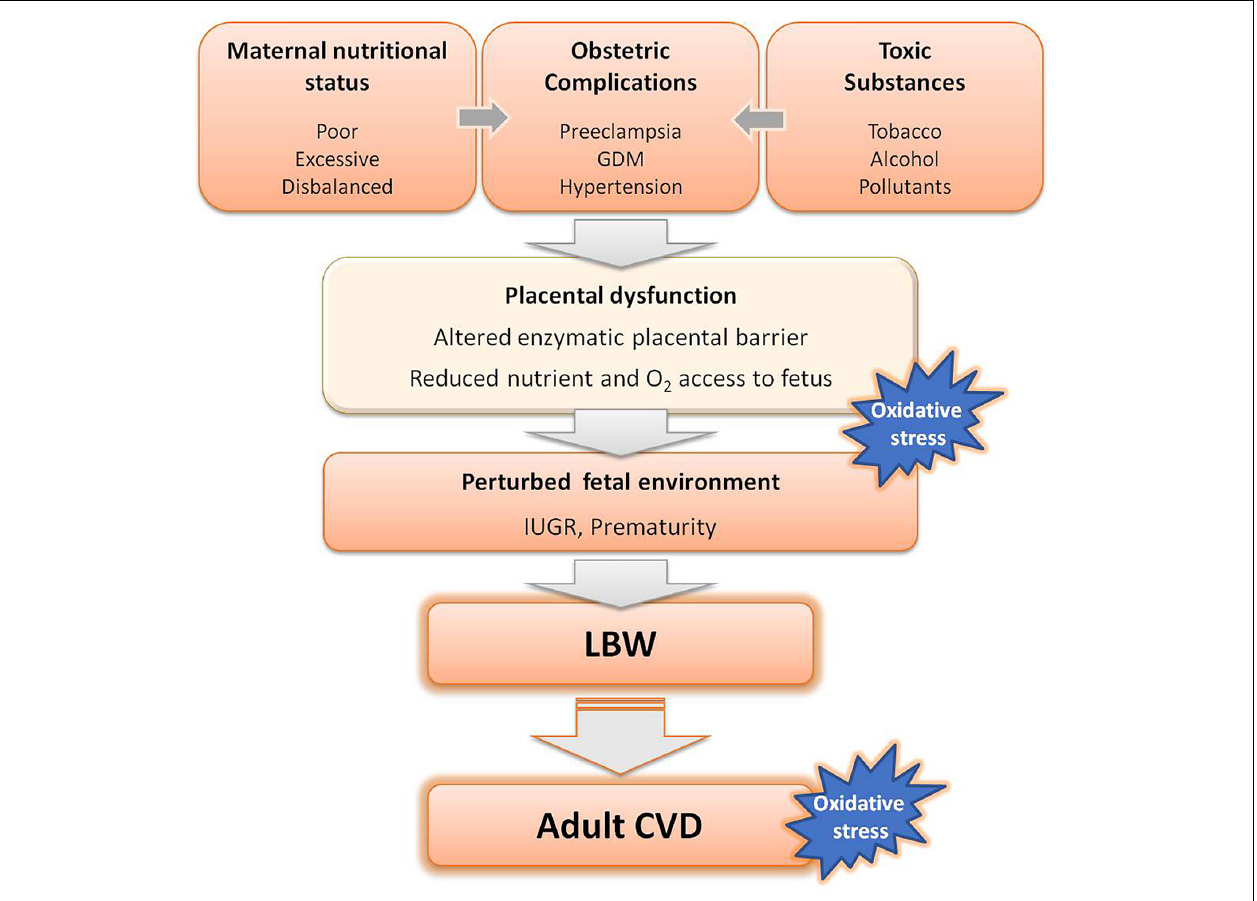
FIGURE 1 | Adverse factors known to interfere with fetal growth leading to low birth weight (LBW) and subsequent development of cardiovascular diseases (CVD) in adult life. GDM, gestational diabetes